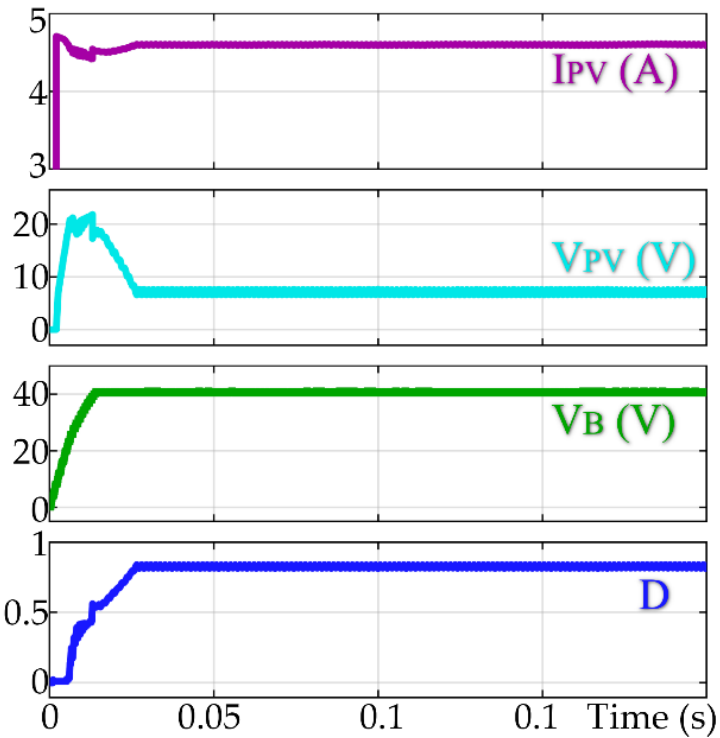
Figure 10. Simulation voltage regulation at 838 W/m 2 and 32 °C. Table 4. Experimental voltage regulation results at different irradiance